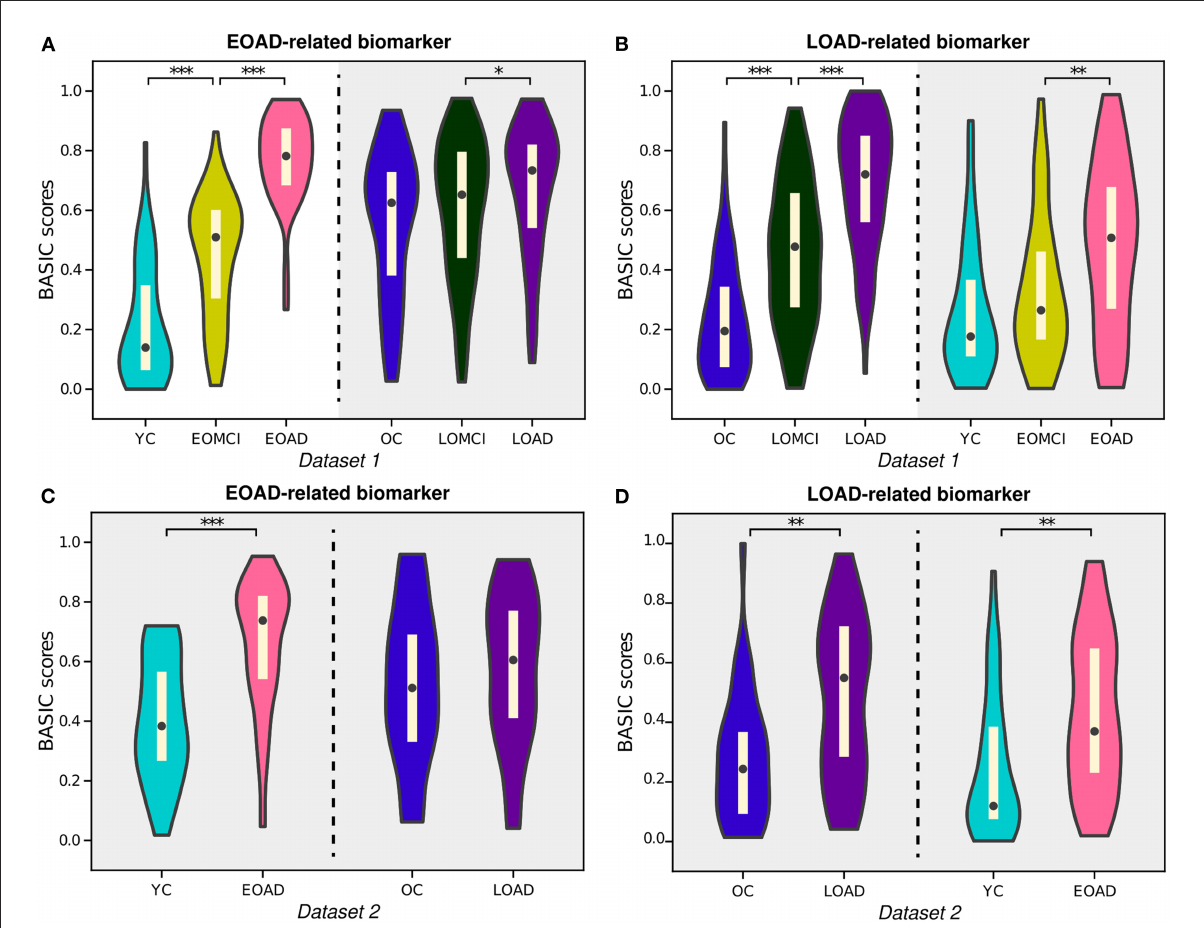
FIGURE6 Violin plots depicting the estimated distributions of BASIC scores associated with the progression of early-onset Alzheimer’s disease (EOAD) and late-onset Alzheimer’s disease (LOAD). (A) EOAD-related biomarker scores were determined using three st ages in the EOAD trajectory using Dataset 1, including young cognitively unimpaired (YC) individuals and patients with early-onset mild cognitive impairment (EOMCI) and EOAD. The scores of the individuals in Dataset 1 were also calculated for the LOAD trajectory, which included old cognitively unimpaired (OC) individuals and patients with late-onset mild cognitive impairment (LOMCI) and LOAD. (B) LOAD-related biomarker scores were similarly determined for the individuals in Dataset 1. (C) EOAD-related biomarker scores of individuals in Dataset 2 were computed for the corresponding disease trajectories with parameters obtained from Dataset 1. (D) LOAD-related biomarker scores of individuals in Dataset 2 were computed for the corresponding disease trajectories with parameters obtained from Dataset 1. The p -values ( p perm ) were computed by permutation testing with 10,000 permutations. * p < 0.05, ** p < 0.01, and *** p < 0.001, with the false discovery rate correction for in each